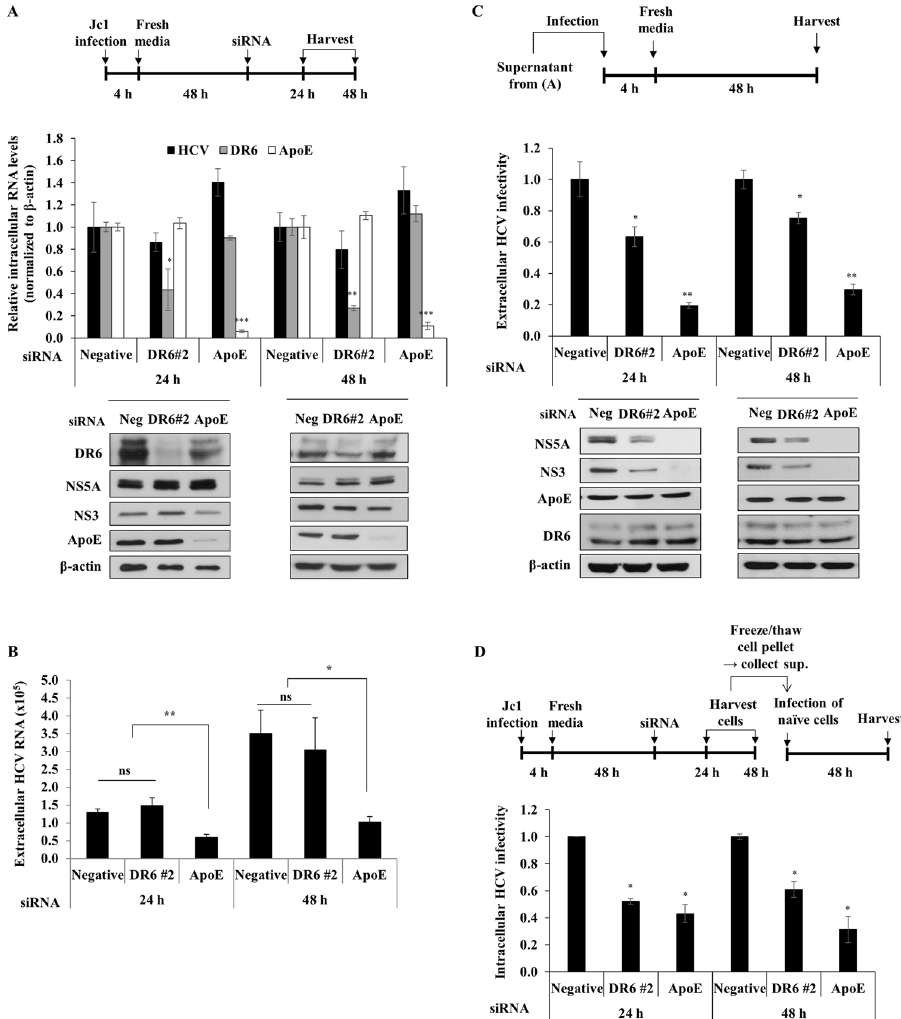
Figure 8. DR6 is required for a late step of the HCV life cycle. ( A ) (Top panel) Schematic illustration of the experimental design. Huh7.5 cells were infected with Jc1 for 4 h. At 48 h postinfection, cells were transfected with 20 nM of the indicated siRNAs. At the indicated time points, both intracellular RNA (middle panel) and protein (bottom panel) were determined by qRT-PCR and immunoblot assays, respectively. siRNA targeting ApoE was used as a positive control for HCV assembly. ( B ) Copy numbers of extracellular HCV RNA in supernatant collected from ( A ) were analyzed by qRT-PCR. ( C ) Naïve Huh7.5 cells were infected with Jc1 harvested from culture supernatant of panel A. At the indicated time points after infection, both extracellular HCV infectivity (upper panel) and protein (lower panel) levels were determined by qRT-PCR and immunoblot assays, respectively. ( D ) (Upper panel) Schematic illustration of the experimental design. (Lower panel) Huh7.5 cells treated as described in ( A ) were lysed with three freeze-thaw cycles and centrifuged at 15,000 × g for 15 min. The cellular supernatant was collected and used to infect naïve Huh7.5 cells. At 48 h postinfection, relative intracellular HCV infectivity was determined by qRT-PCR. Negative indicates universal control siRNA. All experiments were performed in